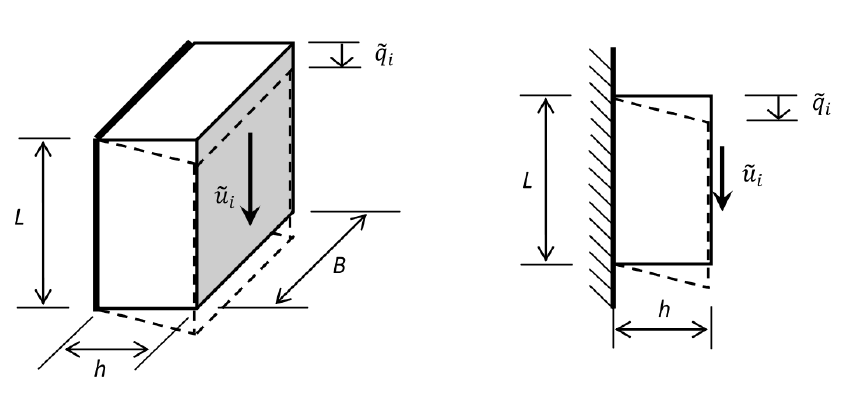
Figure 4. The desired dimensions of the sample tested in the shear